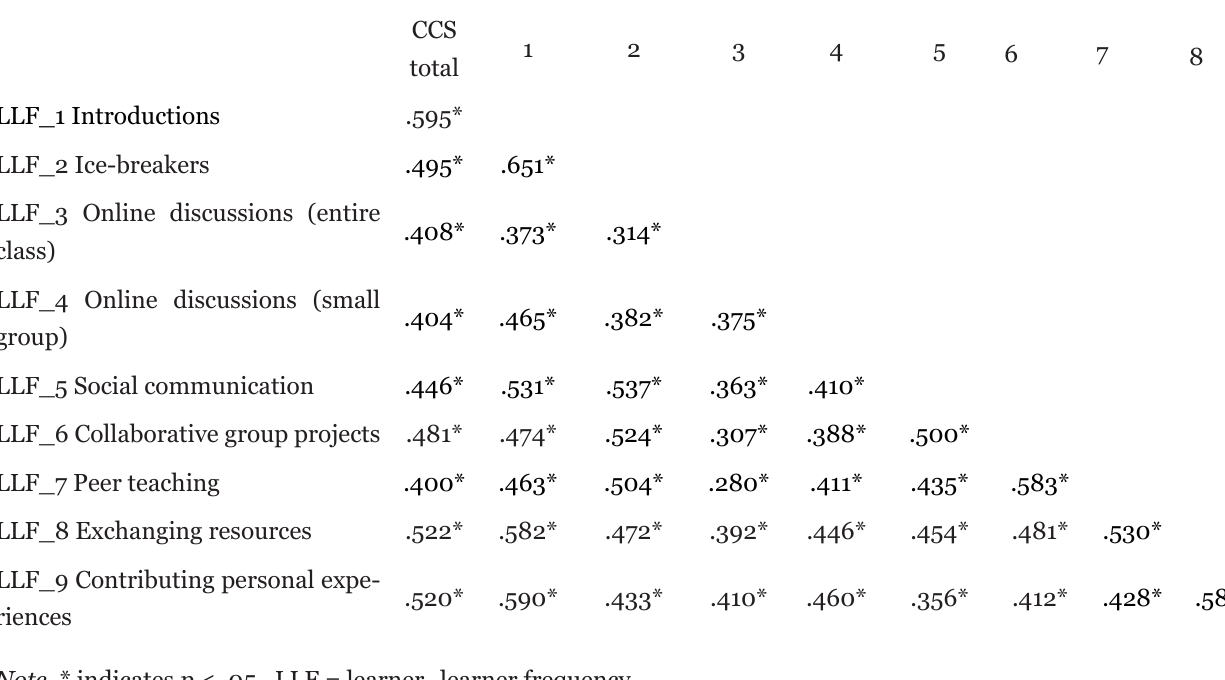
Correlations Between CCS Total Score and L – L Frequency